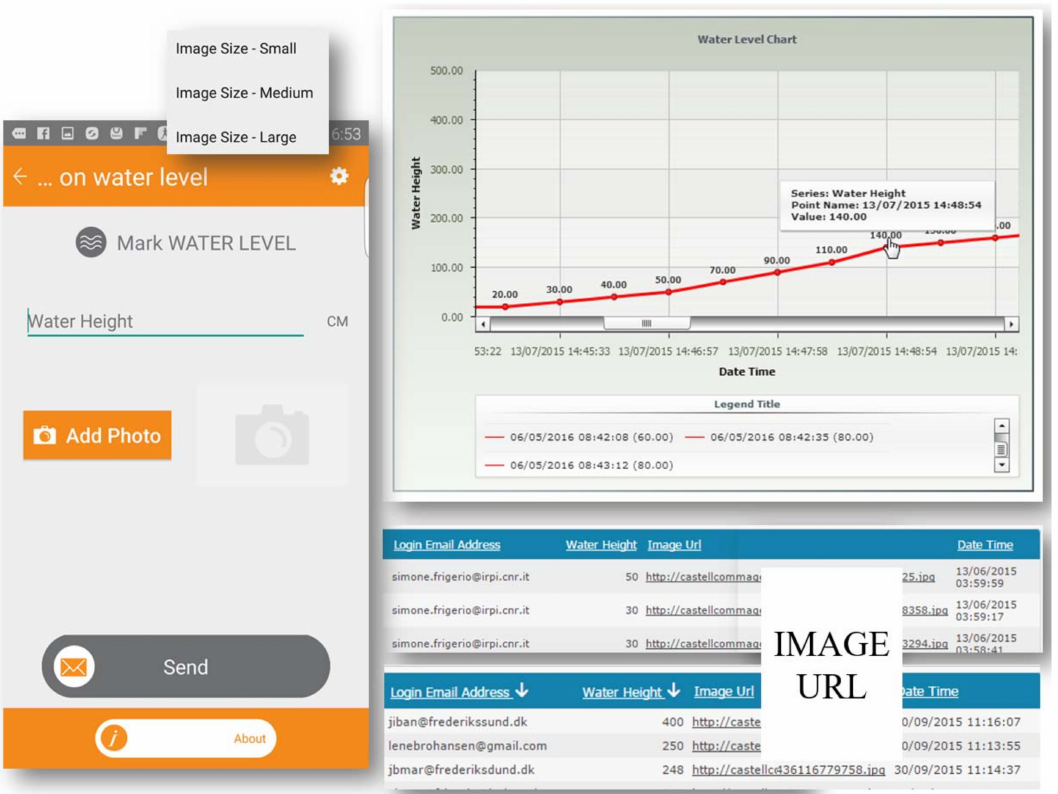
Figure 2. Water level marked with photo appears continuously in a chart